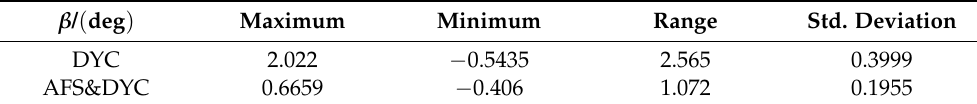
Table 5. Sideslip angle under high-speed